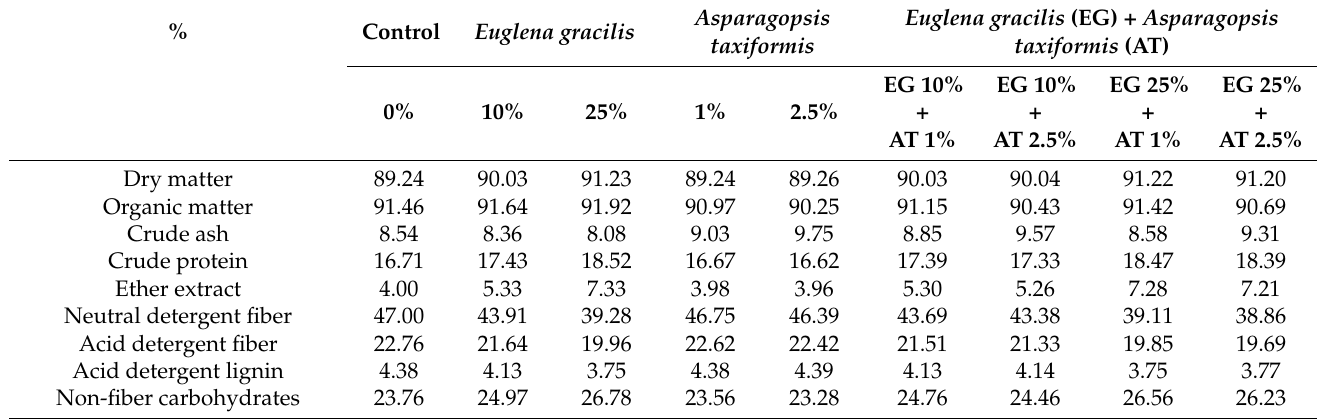
Table 4. Chemical composition (% in dry matter) of the experimental treatments with the combination of Euglena and Asparagopsis